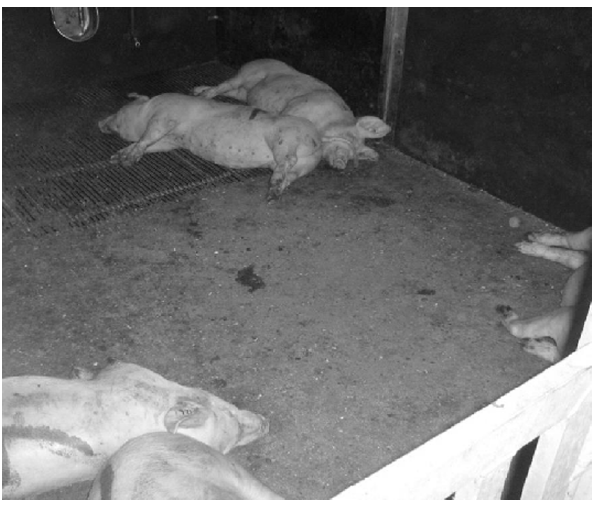
Figure 2. Pigs resting closely together with their familiar pig while resting far apart from unfamiliar